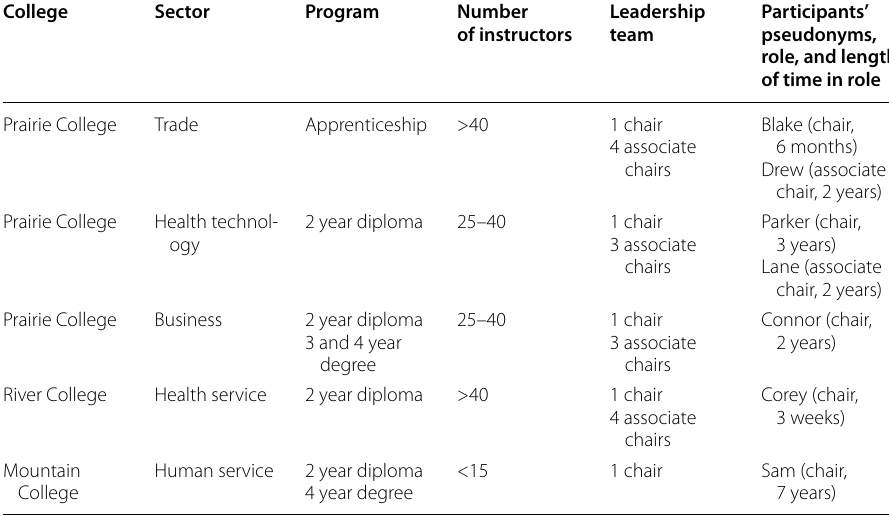
Table 1 Overview of Sites and